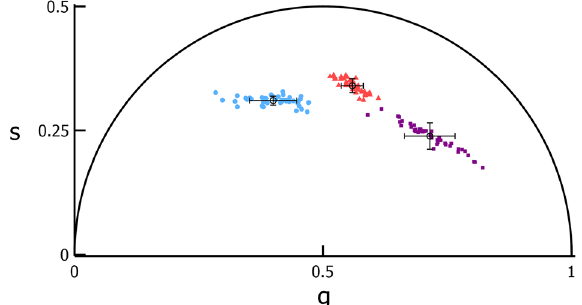
Figure 2. Grouping of photoreceptor phasor coordinates into distinct clusters. Average phasor coordinates of two cone clusters (“Cluster 1”, blue circles; “Cluster 2”, red triangles) and one rod cluster (“Cluster 3”, purple squares) for 43 initial exposure locations in 3 monkeys. Within each cluster, one point represents one cone cluster within an